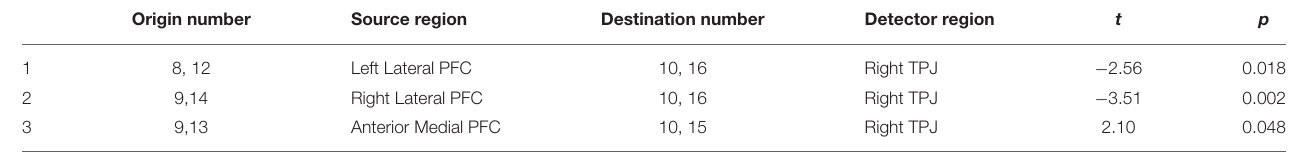
TABLE 2 | Maternal depressive symptoms on neural connectivity.